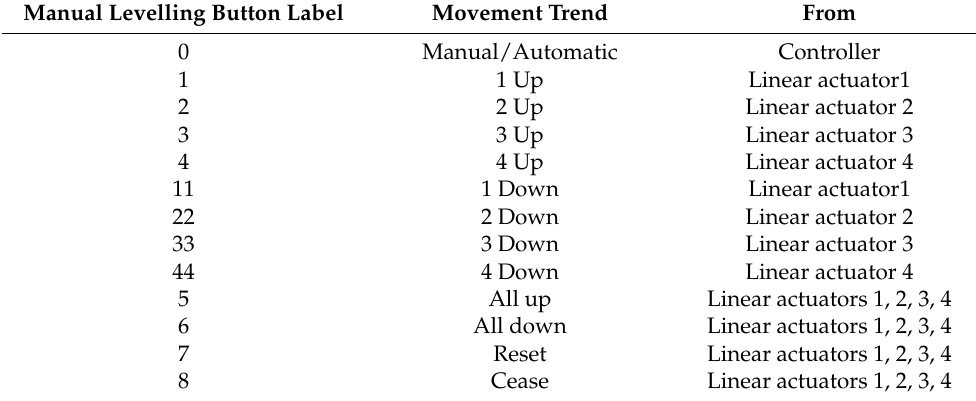
Table 1. Switch signal